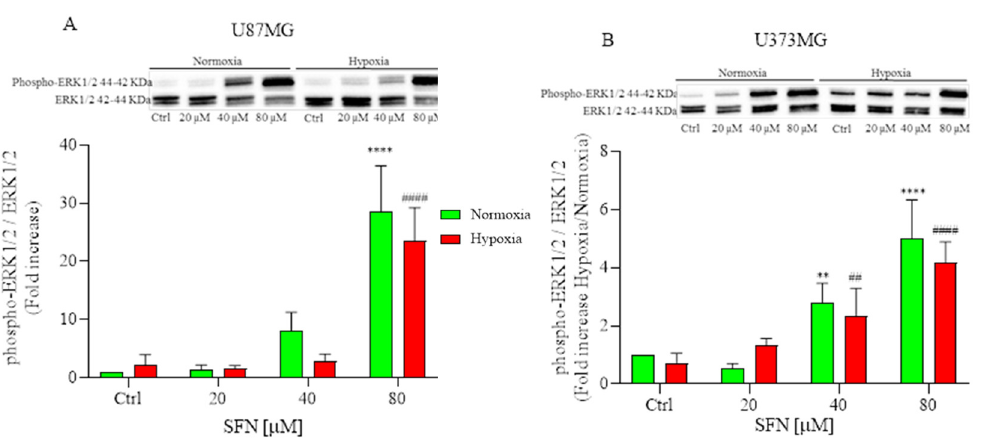
Figure 5. Effects of SFN on MAPK signaling pathway after 48 h of treatment [20–80 µM] in normoxic (green) or hypoxic (red) conditions. Top: representative images of phospho-ERK1/2 and total ERK1/2 expressions in U87MG ( A ) and in U373MG ( B ) cells. Bottom: quantitative analysis of the Western Blotting results. In U87MG cells ( A ) SFN treatment induced the phosphorylation of ERK at 80 µM, while in U373MG cells ( B ) the phosphorylation was dose-dependent both in hypoxic and normoxic conditions. Data are expressed as fold increases and reported as mean ± SD of three independent experiments. (** p < 0.01, **** p < 0.0001 vs. normoxic Ctrl group, ## p < 0.01, #### p < 0.0001 vs. hypoxic Ctrl group. Two-way ANOVA, post hoc test Bonferroni).